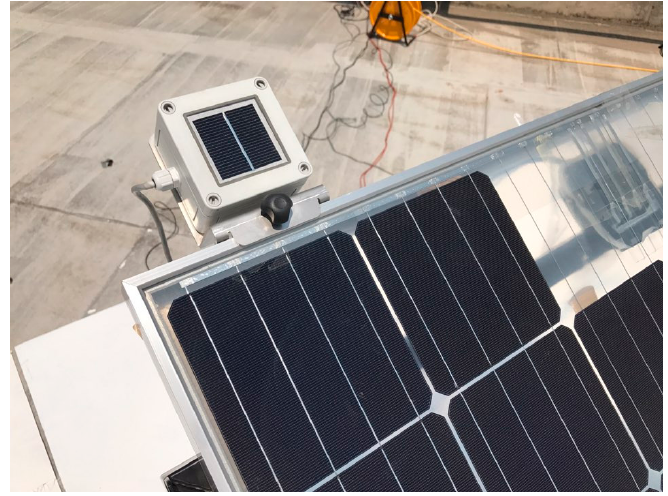
Figure 17. Pyranometer installed on the back of the modules.